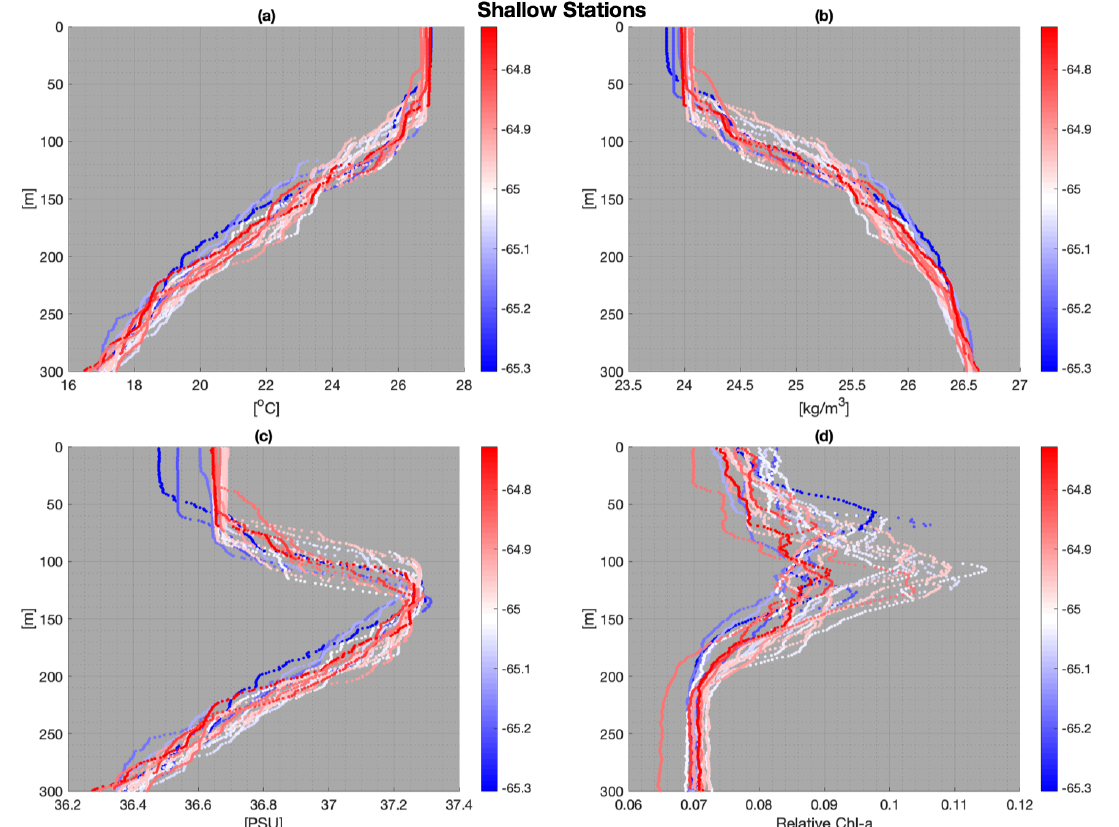
Figure 6. ( a ) Temperature, ( b ) density, ( c ) salinity, and ( d ) relative Chl-a profiles for shallow stations. Color represents their location by